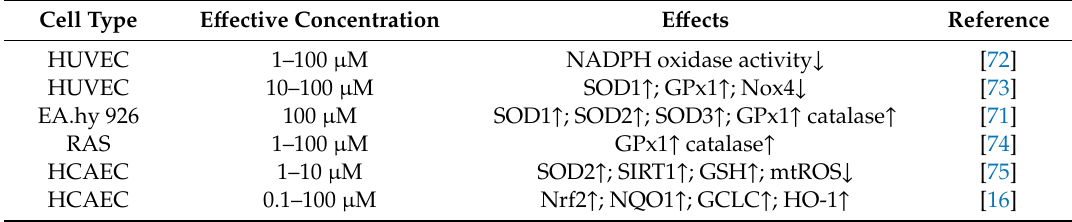
Table 2. Resveratrol reduces oxidative stress in endothelial